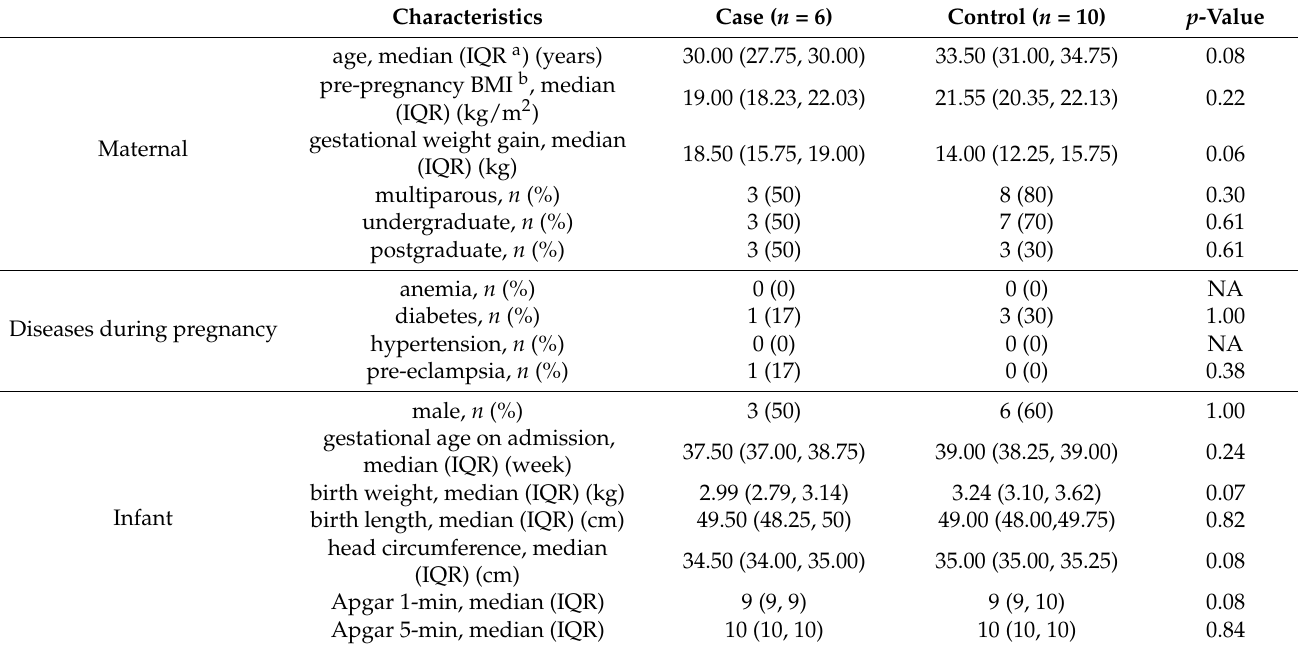
Table 1. Clinical characteristics of sample donors.